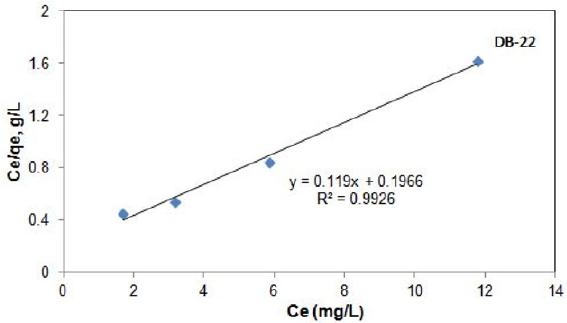
Fig. 11. Langmuir isotherm for DB-22 onto KZF (pH: original, tem- perature: 40 °C, adsorbent: KZF, adsorbent amount: 1 g/200mL)